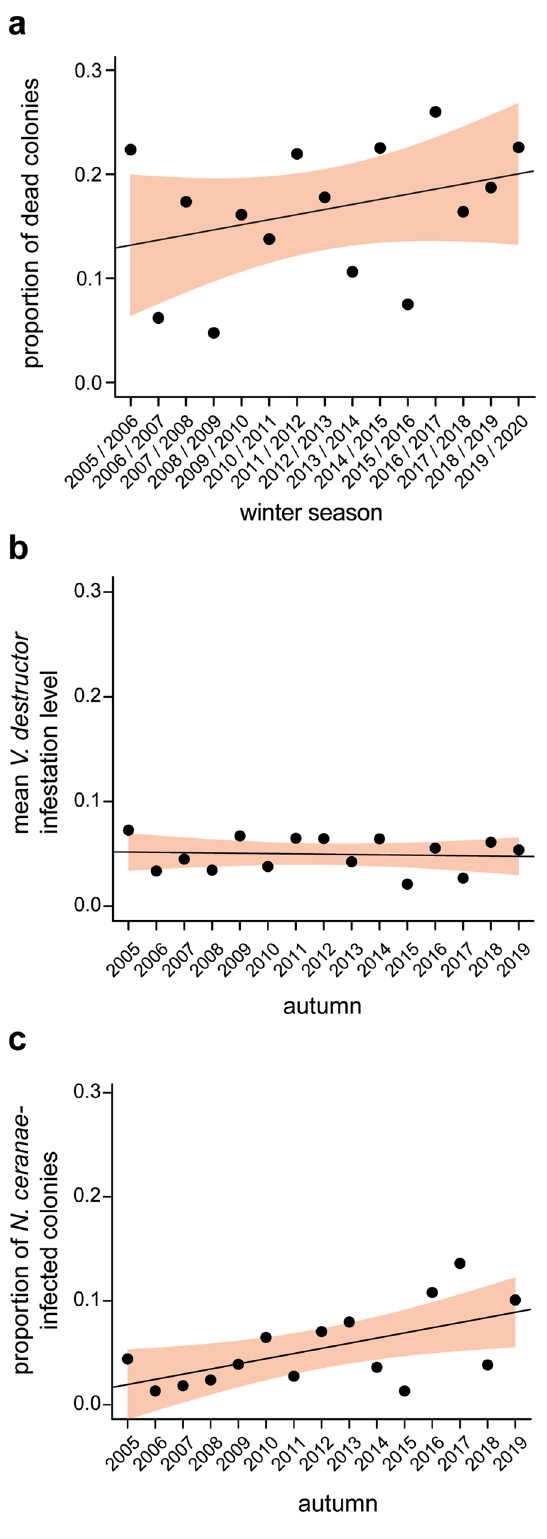
Fig. 1 Dynamics of honey bee colony losses, V. destructor infestation rates, and N. ceranae infection prevalence within a cohort of monitored honey bee colonies. Honey bee colony losses over winter ( a ), V. destructor infestation levels in October ( b ), and N. ceranae infection prevalence in autumn ( c ) were monitored over the study period from 2005 to 2020. Each data point represents the proportion of dead colonies in spring ( n = 3502), the mean mite load per 100 bees in October ( n = 3492) or the prevalence of N. ceranae -infected colonies in autumn ( n = 3502) per year. Linear regression models were calculated. Their regression lines are shown and their 95% CI (con fi dence interval) are highlighted in